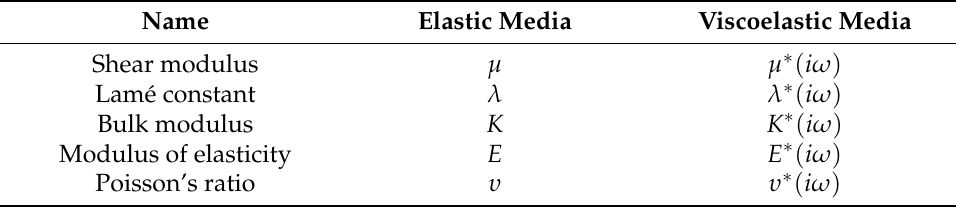
Table 2. Correspondence between elastic and viscoelastic